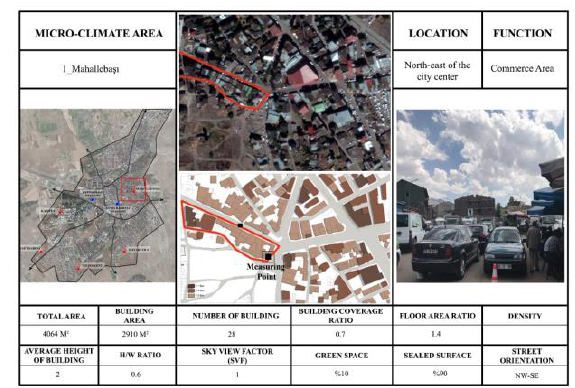
Figure 3.Spatial Analysis of